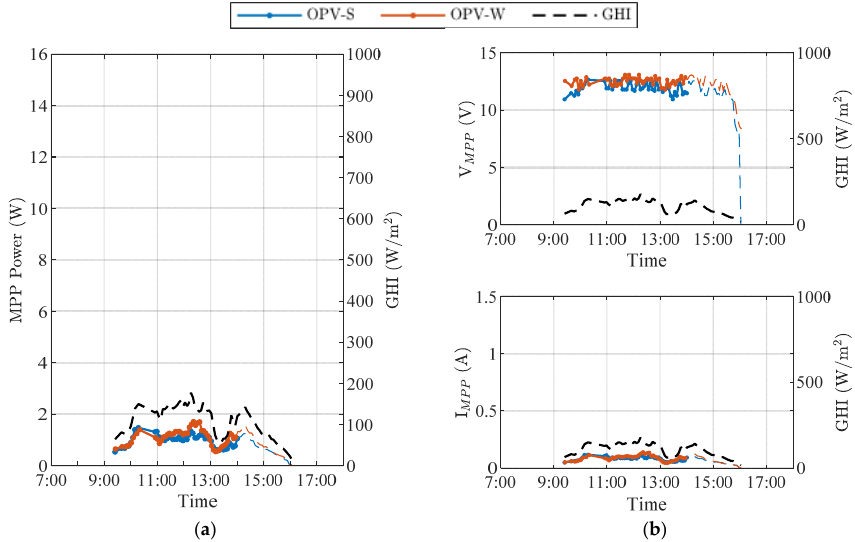
I sc , recorded on 11 February 2021.